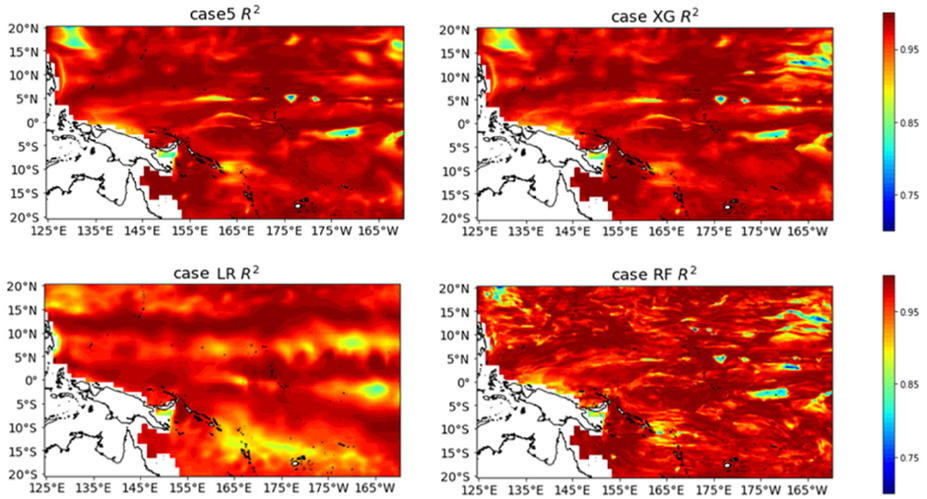
Figure 4. Spatial distribution of R 2 for different models in November 2016.